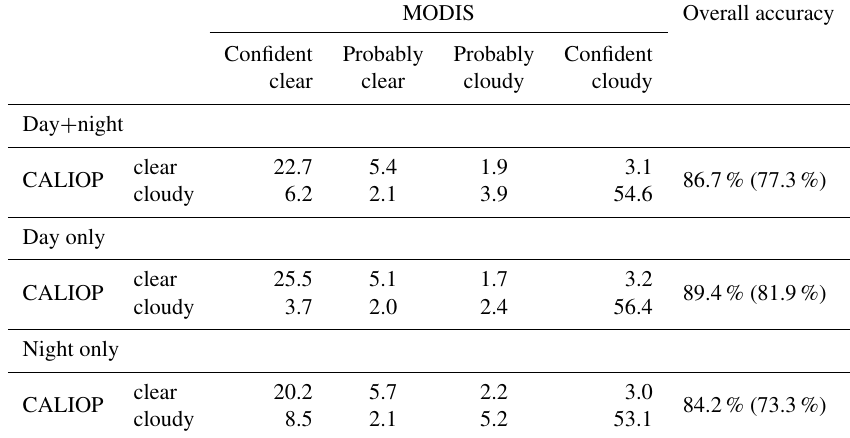
Table 1. Agreement in cloud detection between MODIS and CALIOP (percentage of all cases). Overall accuracy (given in brackets) refers to confident clear and confident cloudy detections. In other cases, confident clear and probably clear were merged, as were probably cloudy and confident cloudy.